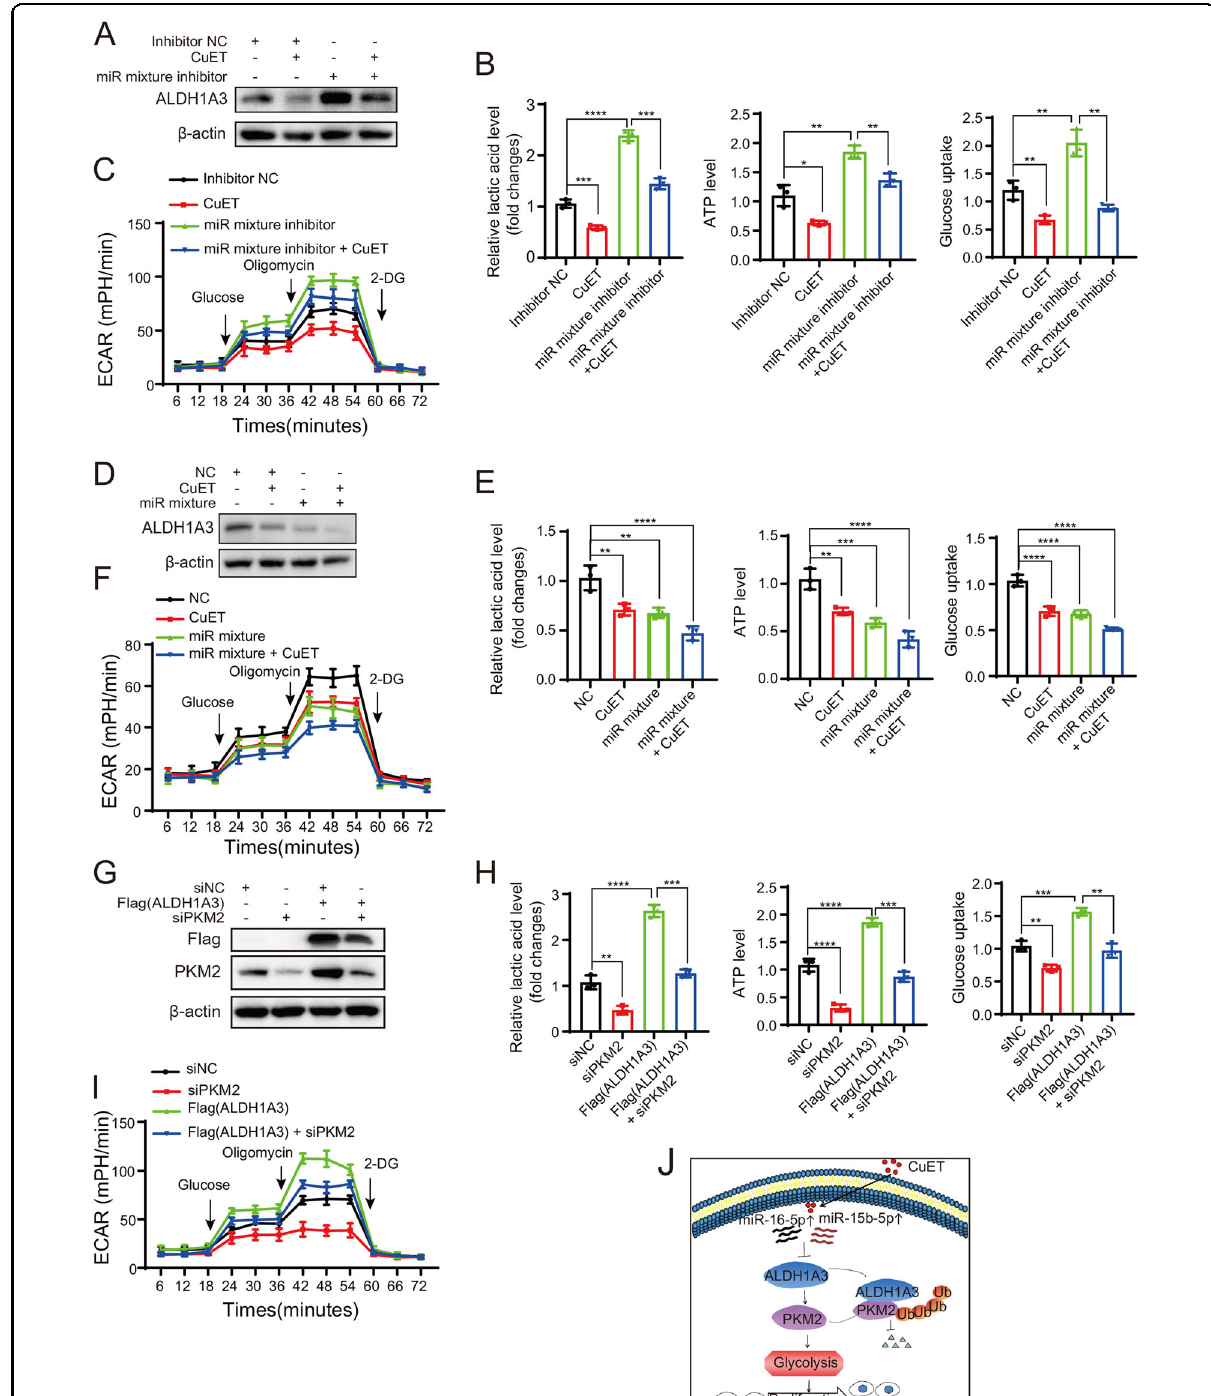
Fig. 7 miR-16-5p, miR-15b-5p/ALDH1A3 axis regulates glycolysis in vitro. a Western blot showed the expression of ALDH1A3 in HCT116 cells treated with CuET, transfected with inhibitor NC, mixture inhibitors, or mixture inhibitors plus CuET treatment. b , c Their lactate production, ATP level, glucose uptake ( b ) and ECAR ( c ) were determined respectively. d Western blot showed the expression of ALDH1A3 in HCT116 cells treated with CuET, transfected with NC, mixture mimics or mixture mimics plus CuET treatment. e , f Their lactate production, ATP level, glucose uptake ( e ) and ECAR ( f ) were determined respectively. g Western blot showed the expression of PKM2 in HCT116 cells transfected with siNC, PKM2 siRNA, Flag- tagged ALDH1A3 plasmid, or PKM2 siRNA plus ALDH1A3 plasmid. h , i Their lactate production, ATP level, glucose uptake ( h ), and ECAR ( i ) were determined respectively. Data shown are mean±SD of three independent experiments, ** p < 0.01, *** p < 0.001, **** p < 0.0001. j The working model depicts the mechanism of CuET modulating glycolytic metabolism through miR-16-5p and miR-15b-5p/ALDH1A3/PKM2 axis.